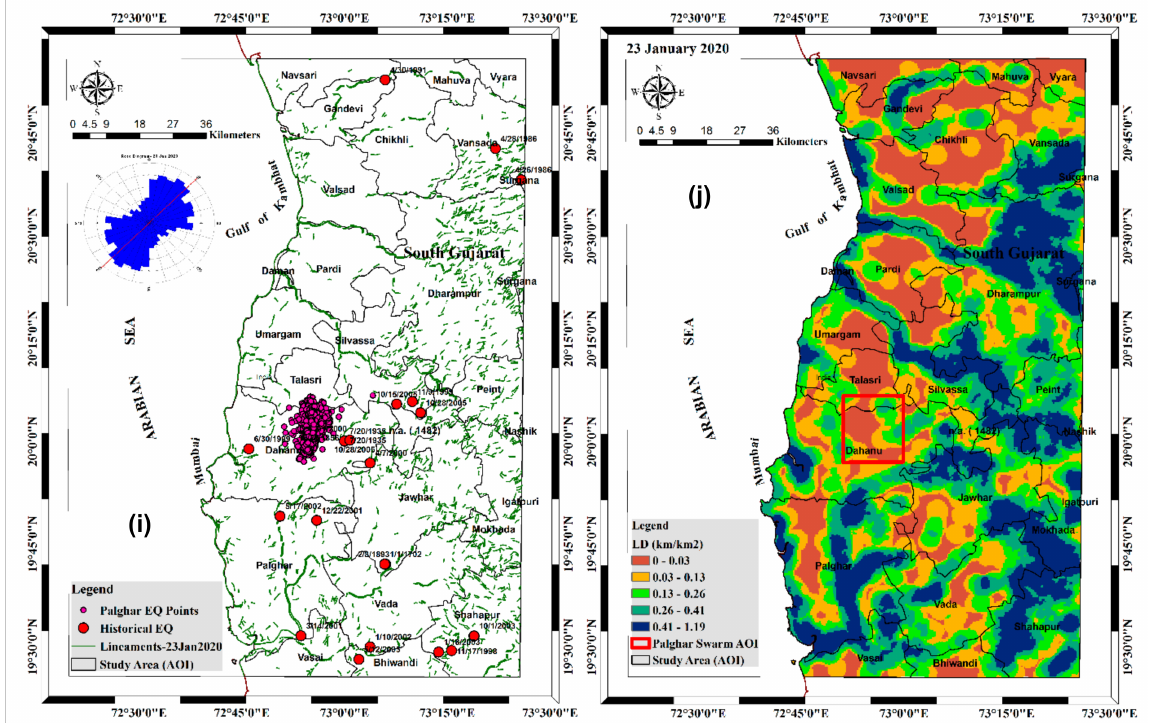
Figure 4. Lineaments and lineaments density (LD) distribution of the study areas (broad regions) dur- ing 2000–2020; ( a ) lineaments of the year 2000 is associated with the past earthquakes; ( b ) lineament density generated based on lineaments of the year 2000; ( c ) lineaments retrieved during the year 2015 with past earthquakes; ( d ) lineament density generated based on lineaments of 2015; ( e ) lineaments extracted in the year 2018 earthquakes; ( f ) lineament density generated based on lineaments of 2018; ( g ) lineaments of 2019 with ongoing earthquake swarms and past earthquakes; ( h ) lineament density generated based on lineaments of 2019; ( i ) lineaments of 2020 with available earthquake swarm points and past earthquakes; ( j ) lineament density generated based on extracted lineaments of 2020 to represent the present scenario of stress changes in the study